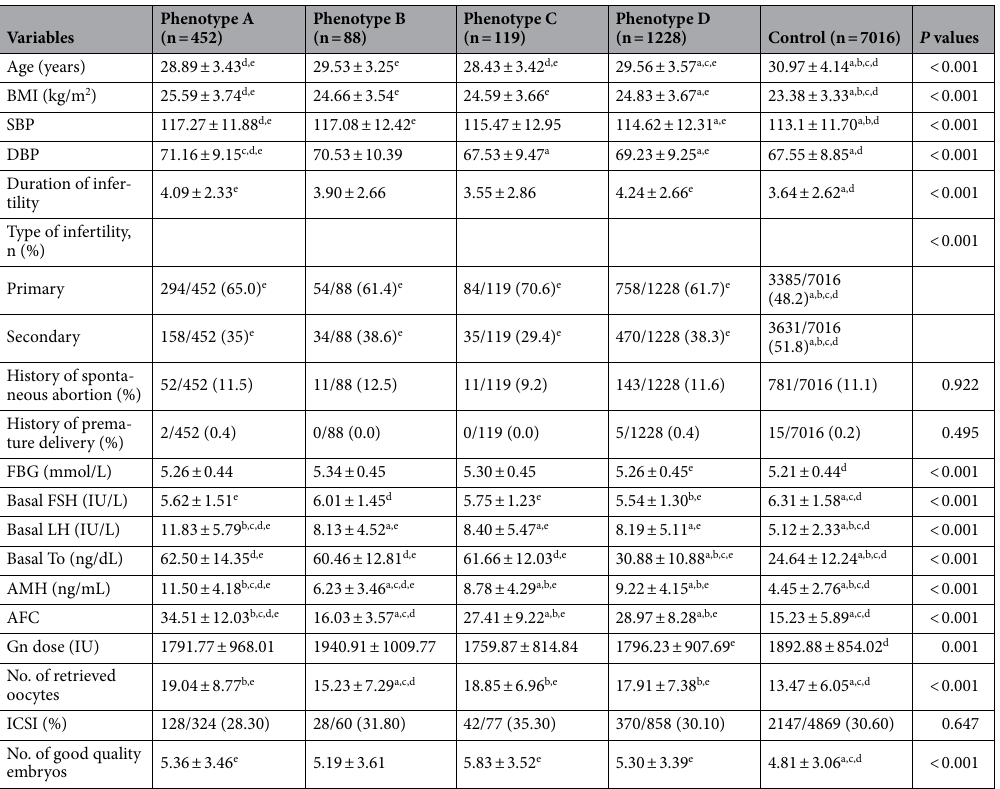
Table 1. Baseline characteristics and ovarian responses of four PCOS phenotype and control groups. AMH, anti-Müllerian hormone; AFC, antral follicle count; BMI, body mass index; DBP, diastolic blood pressure; FBG = fasting blood glucose; FSH = follicle-stimulating hormone; Gn, gonadotropin; HCG, human chorionic gonadotropin; IU, international units; LH, luteinizing hormone; PCOS, polycystic ovary syndrome phenotype; SBP, systolic pressure; To, total testosterone concentration. a P values < 0.05, compared with phenotype A. b P values < 0.05, compared with phenotype B. c P values < 0.05, compared with phenotype C. d P values < 0.05, compared with phenotype D. e P values < 0.05, compared with the control